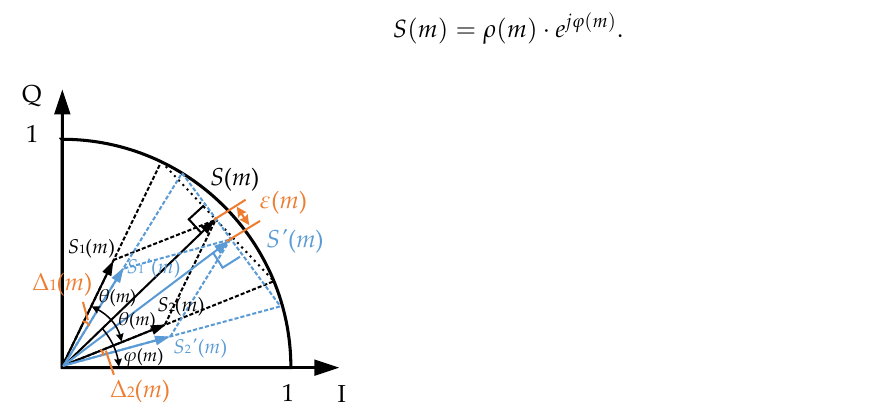
Figure 3. Schematic of the vector decomposition of the original baseband modulated signal. The original signal S ( m ) is decomposed into two phase-shift signals, S 1 ( m ) and S 2 ( m ). The amplitude of both signals is 1/2, and the phase is φ ( m ) + θ ( m ) and φ ( m ) − θ ( m ), respec- tively. Here, θ ( m ) is the phase-shift angle [17], calculated by